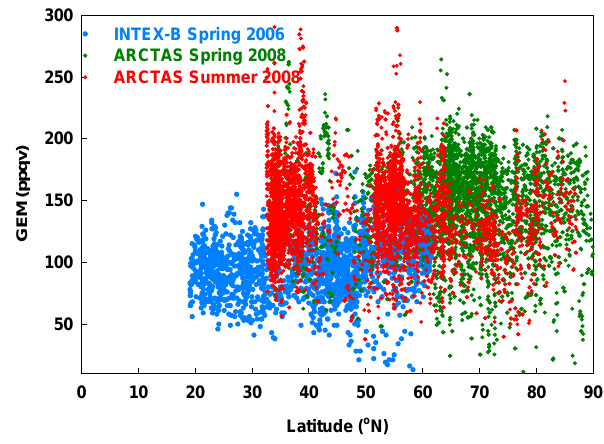
Figure 4. GEM (ppqv) from the INTEX-B in spring 2006 and ARCTAS in spring and summer 2008 (Data sources: Talbot et al., 2007, 2008; Mao et al., 2010).